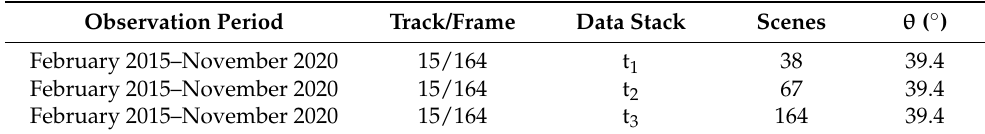
Table 1. Sentinel-1 data that were used in this study and their attributes. All three datasets originate from the same track and frame and use the same observation period, only the number of scenes differs.